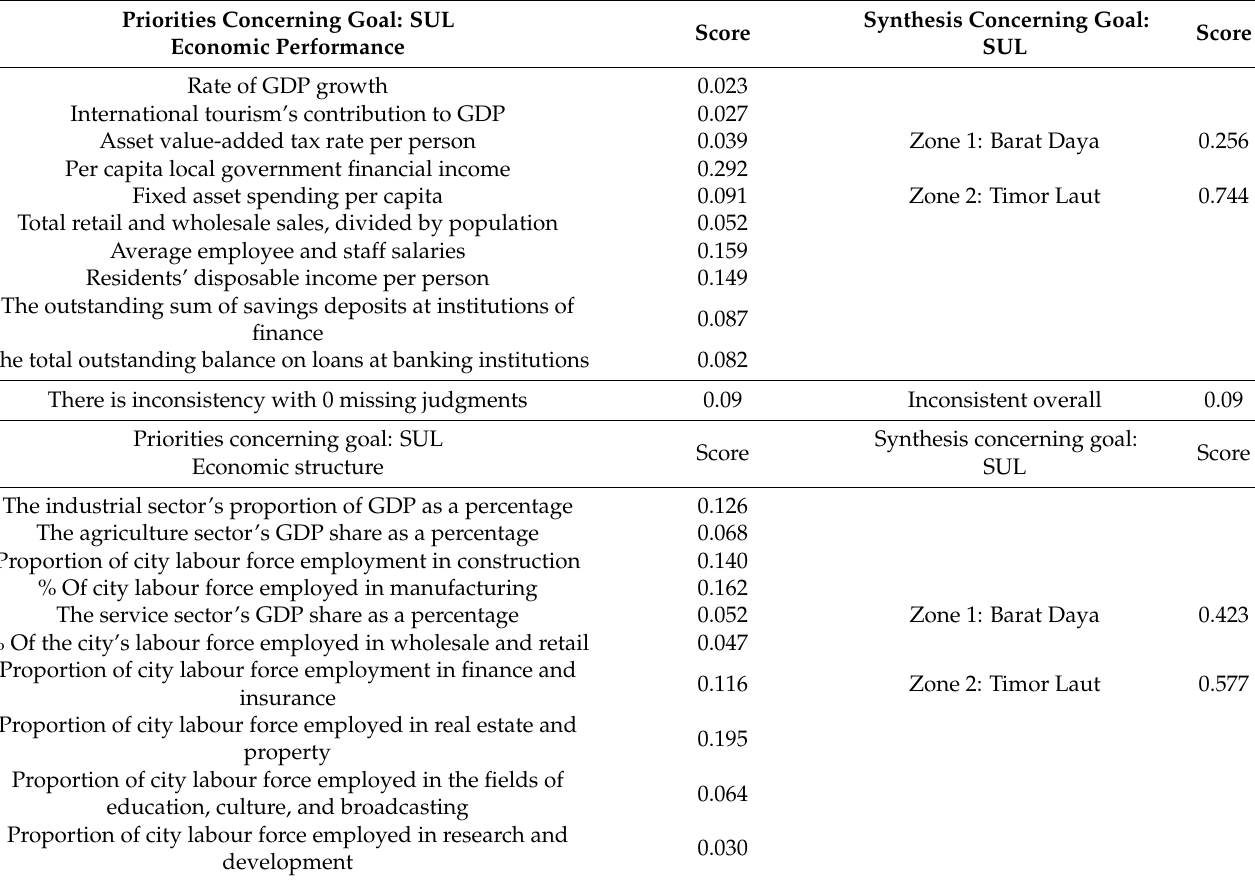
Table 6. Final weights for the economic criteria, sub criteria, and alternatives (zones) of the urban